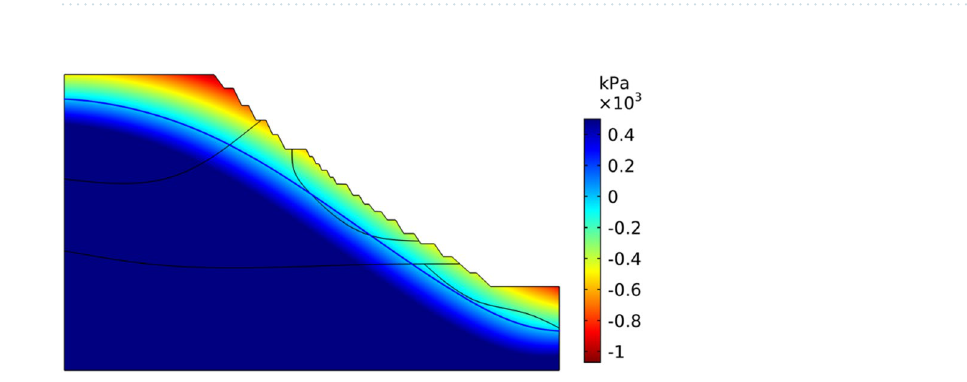
Table 7. Rainfall schemes.